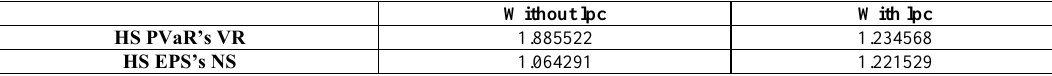
Table 6. Backtest results for Historic Simulation with and without lpc for EPS (NBG